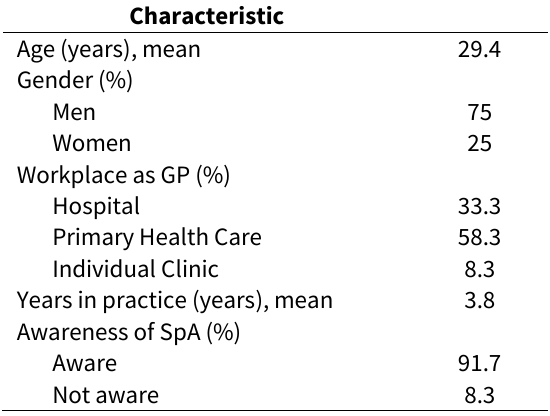
Table 2 . Baseline Characteristics of GP